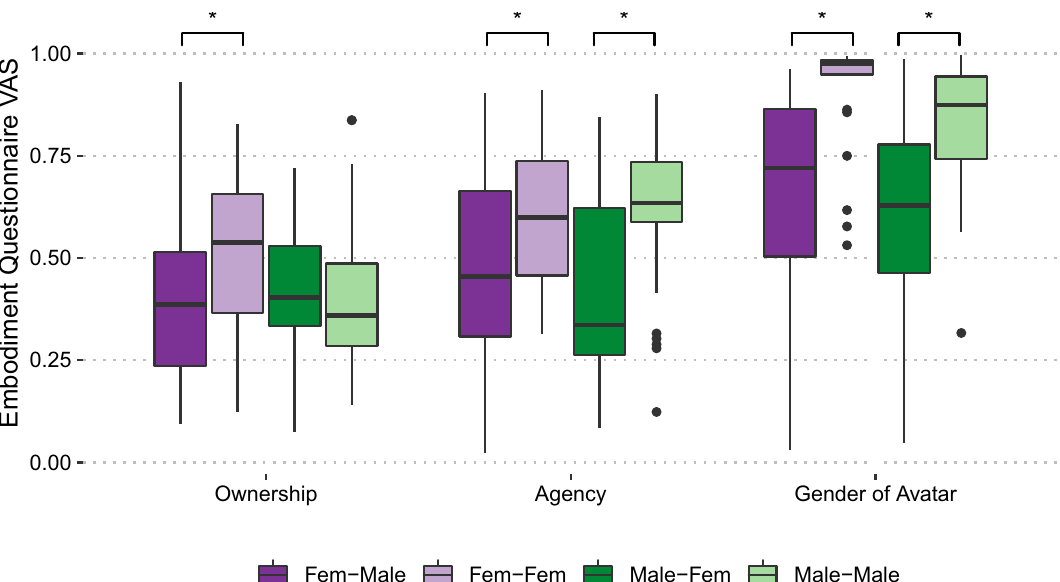
Figure 5. Embodiment questionnaire. Ownership, sense of agency and embodiment of avatar gender ratings. The data are separated by Sex and Group; median and interquartile ranges are displayed. Ownership : ART ANOVA revealed a significant Sex × Group interaction, driven by female participants, who experienced less ownership over their virtual bodies than male participants when swapping into different-gender avatars. Agency : ART ANOVA revealed significant effect for Group: Participants who swapped into a different-gender avatar reported lower agency than those who swapped into a same-gender avatar. Gender of Avatar : ART ANOVA revealed significant effect for Group: Participants who swapped into a different-gender avatar reported lower sense of the avatar’s gender than those who embodied a same-gender avatar; significant difference for Group in agency and sex of